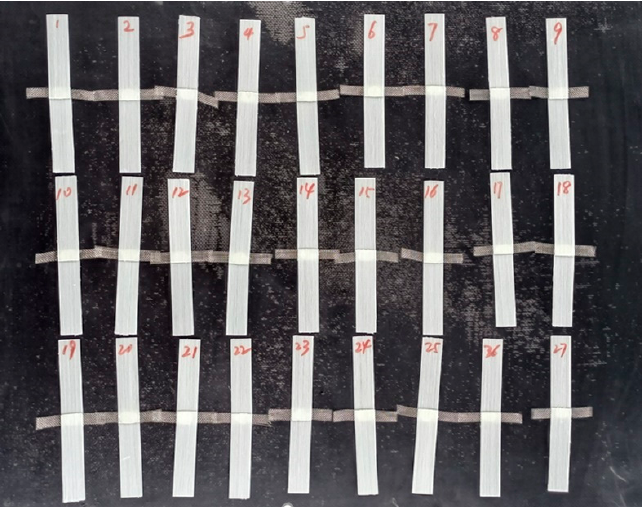
Figure 5. Photograph of test samples.